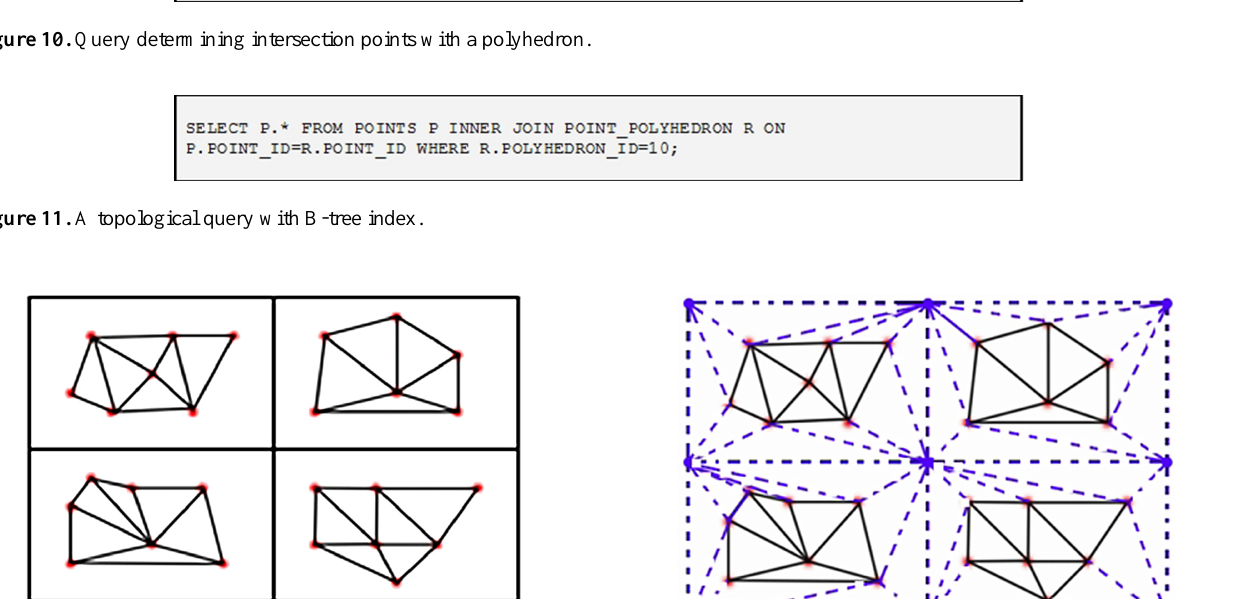
Figure 10. Query determining intersection points with a polyhedron.